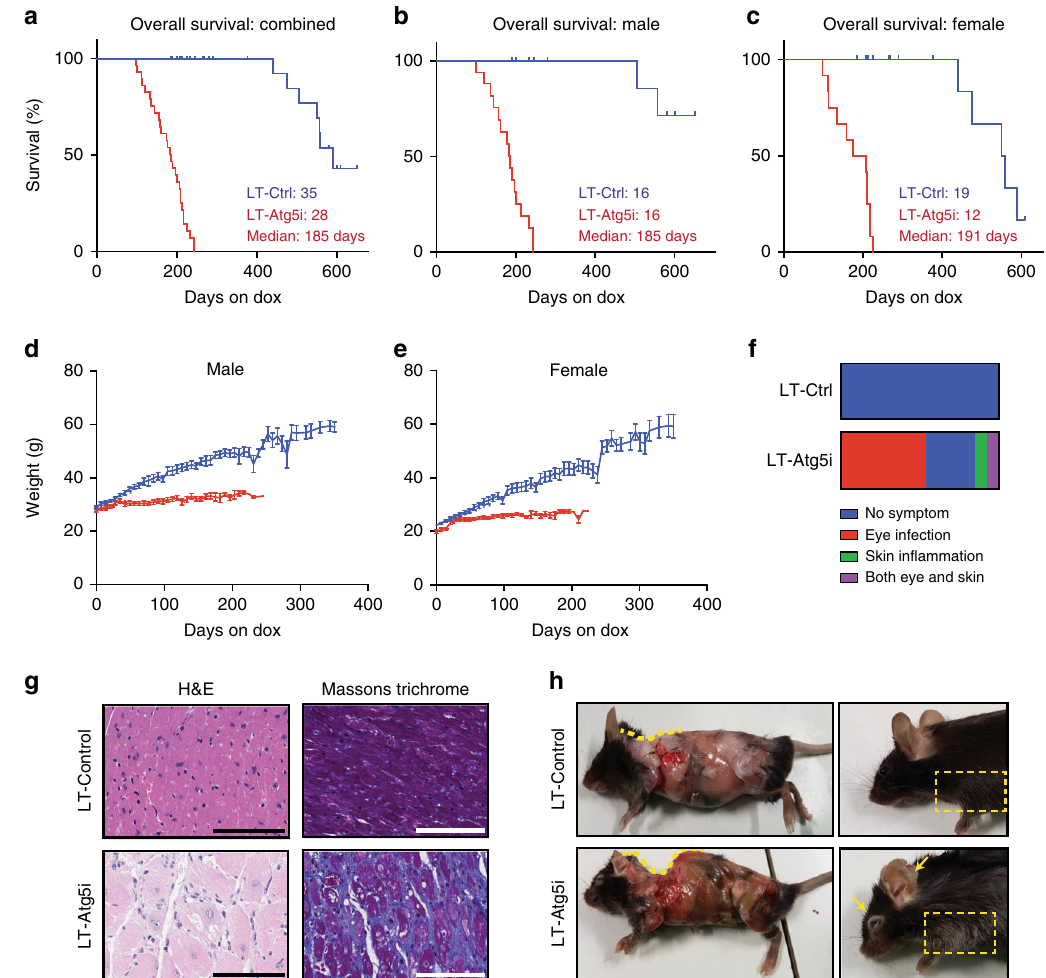
Fig. 1 Autophagy inhibition decreases lifespan. LT-Atg5i mice on dox continuously from 2 months old display a reduced lifespan in comparison with LT- Control as shown in survival graphs for combined ( p < 0.0001) ( a ), male ( p < 0.0001) ( b ), female ( p < 0.0001) ( c ) (Mantel – Cox test). Median survival (days on dox) and mice per group are indicated. During this period LT-Atg5i mice also display a reduced weight gain in both male ( d ) and female ( e ) cohorts. f LT-Atg5i mice also display an increased frequency of skin in fl ammation and eye infections in comparison with age-matched LT-Control mice. g Cardiac fi brosis was also evident in LT-Atg5i mice. Representative images of H&E and Massons Trichrome are shown. Scale bars, 100 μ m. h Age- matched skinned mice. LT-Atg5i mice show kyphosis (yellow dotted line traces the arch of the spine). They often displayed premature greying (dotted rectangle). Arrows indicate the presence of in fl